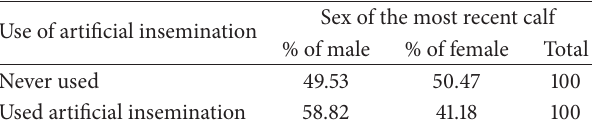
Table 4: Relationship between use of AI and the sex of the calf